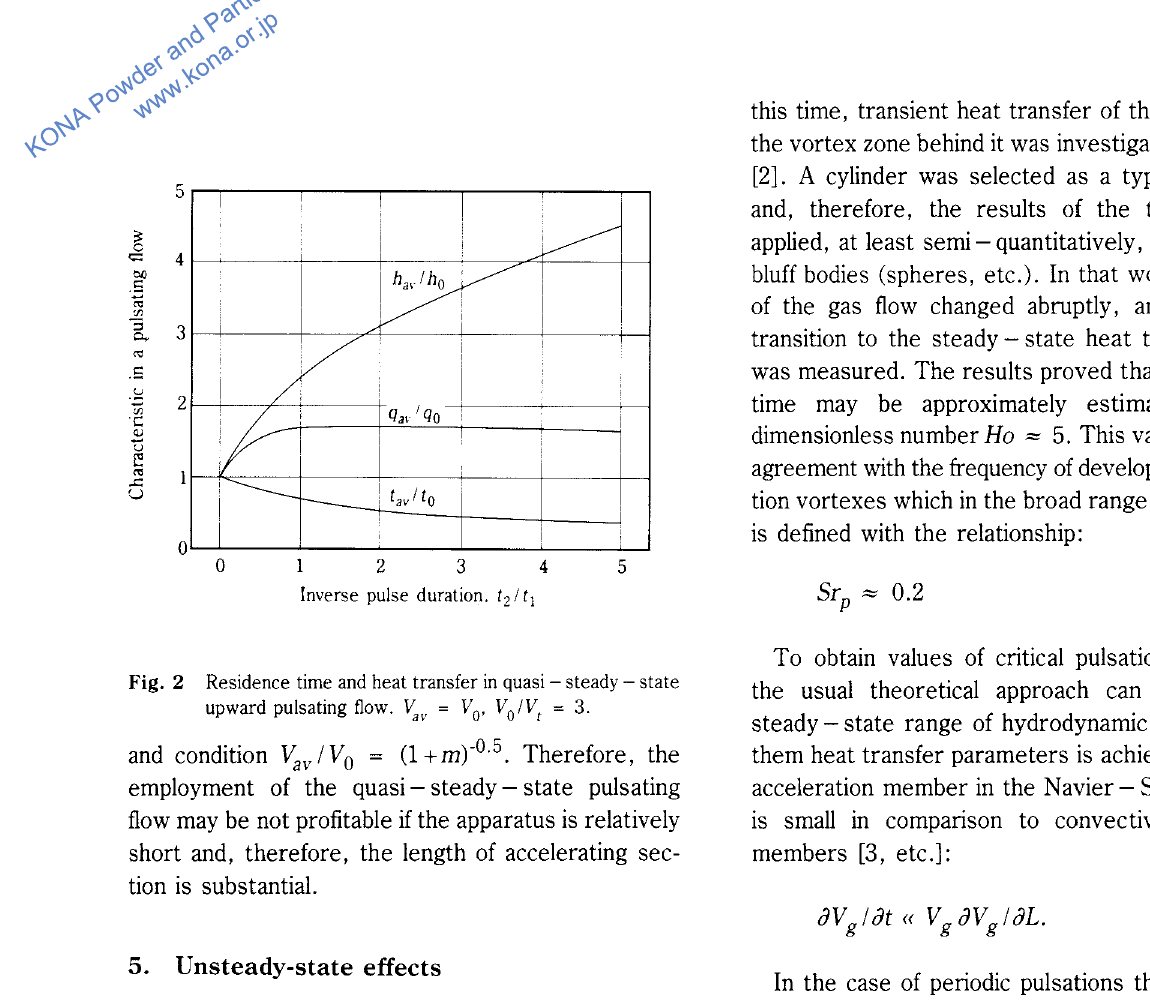
Fig. 2 Residence time and heat transfer in quasi- steady- state upward pulsating flow. ~v = V 0 , V 0 1V 1 =